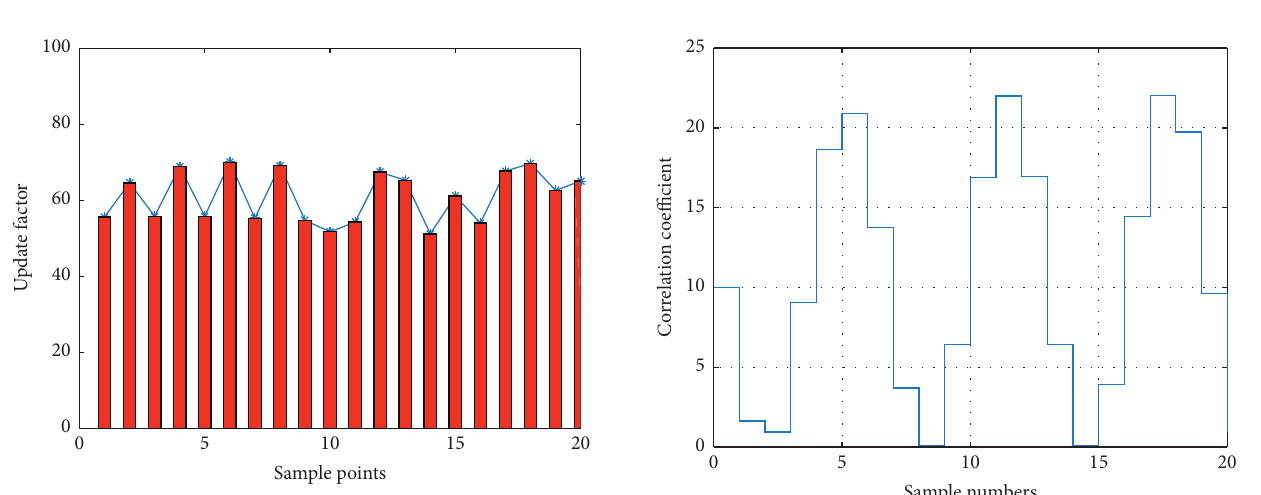
Figure 5: Stability analysis of network knowledge